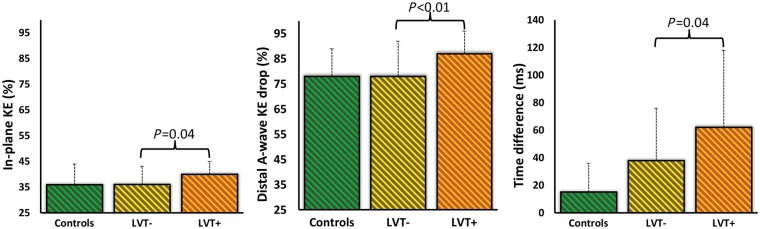
Bar graph of the main LV blood flow kinetic energy parameters which demonstrated significant changes in patients with/without thrombus (whiskers: interquartile range). KE, kinetic energy; LVT−, patients without LV thrombus; LVT+, patients with LV thrombus.